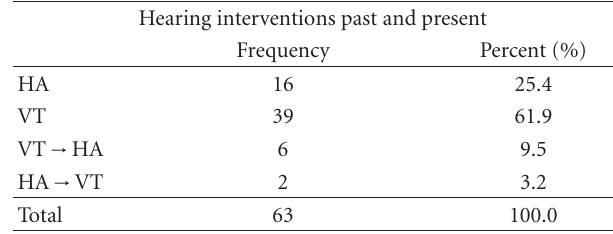
Table 2: Treatments Instituted. VT → HA = ventilation tubes